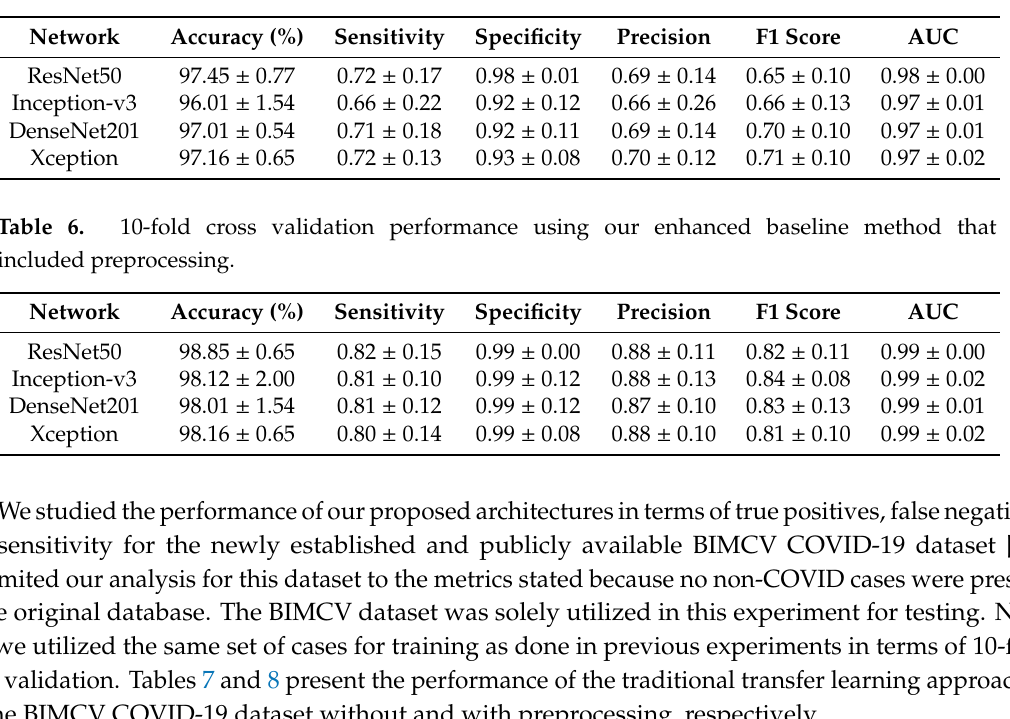
Table 5. 10-fold cross validation performance using our baseline method.